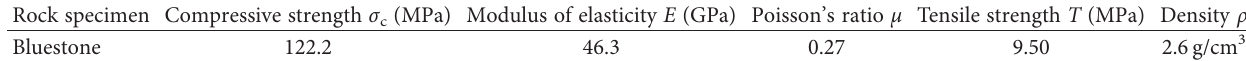
Table 2: Mechanical properties of the